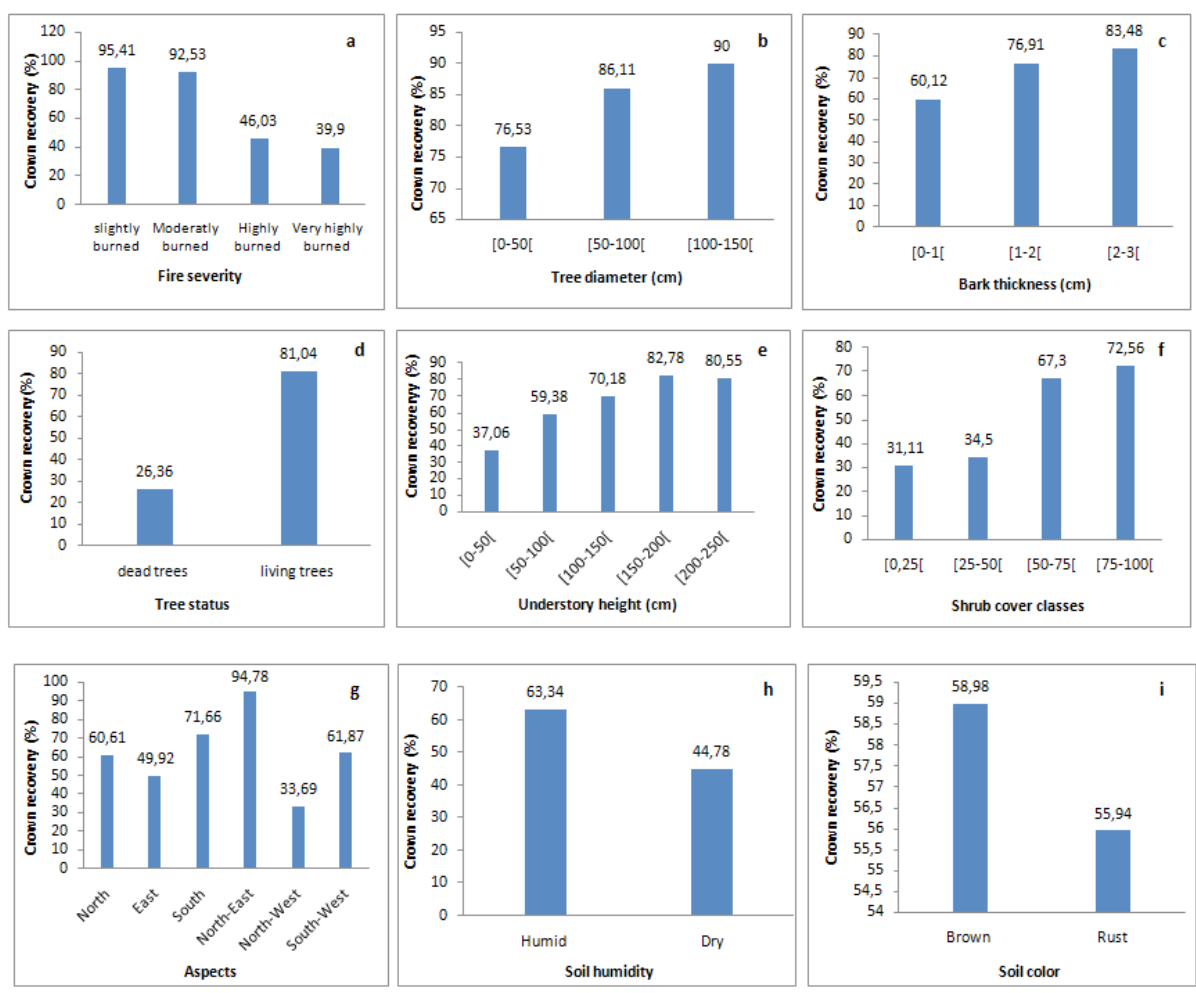
Figure 6. Percentages of trees presenting post-fire crown recovery for each of the highly correlated